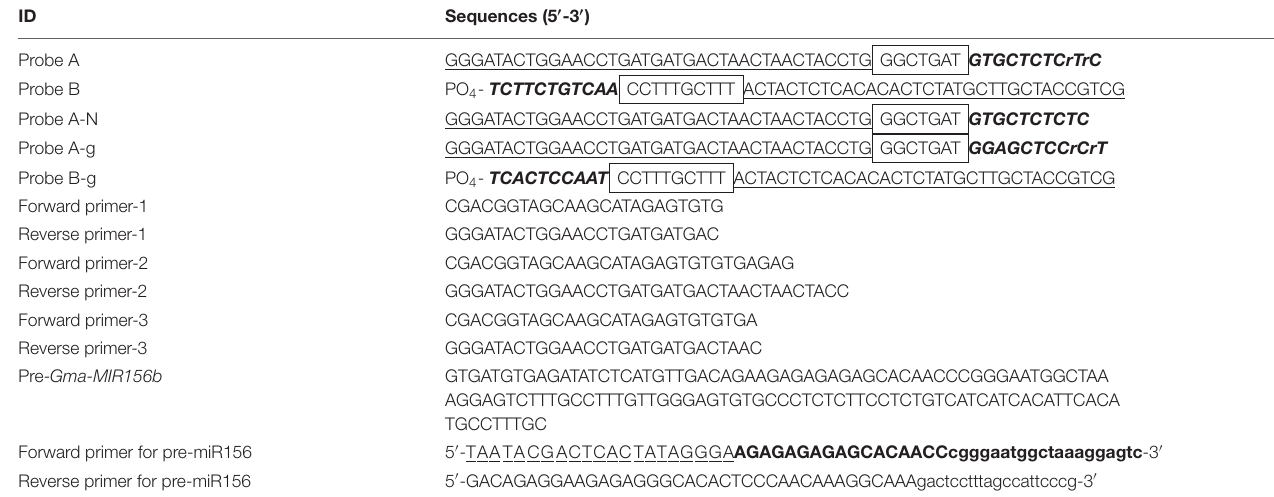
TABLE 1 | The sequences of the primers and probes in the ligation based quantitative polymerase chain reaction (PCR) amplification. Sequences (5 (cid:48) -3 (cid:48)